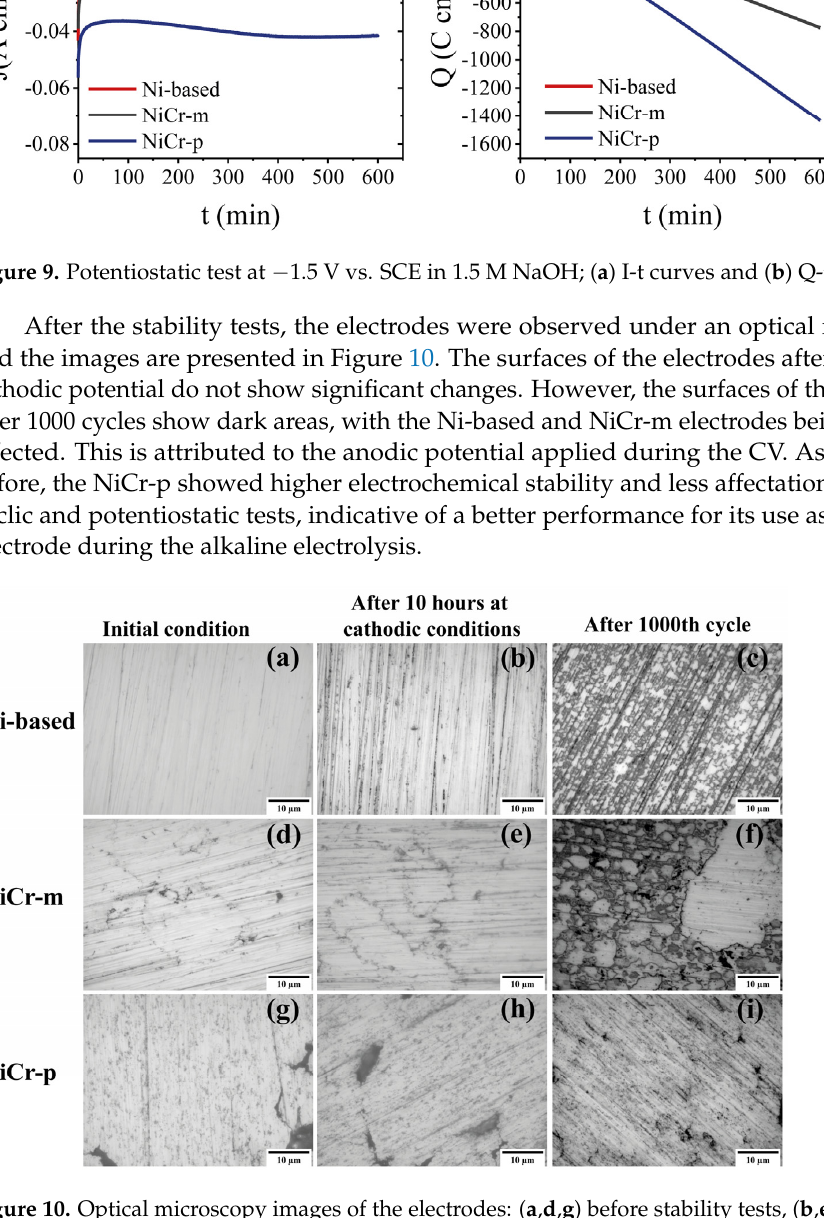
Figure 10. Optical microscopy images of the electrodes: ( a , d , g ) before stability tests, ( b , e , h ) after 10 h at − 1.5 V vs. SCE, and ( c , f , i ) after 1000 cycles. at − 1.5 V vs. SCE, and ( c , f , i ) after 1000